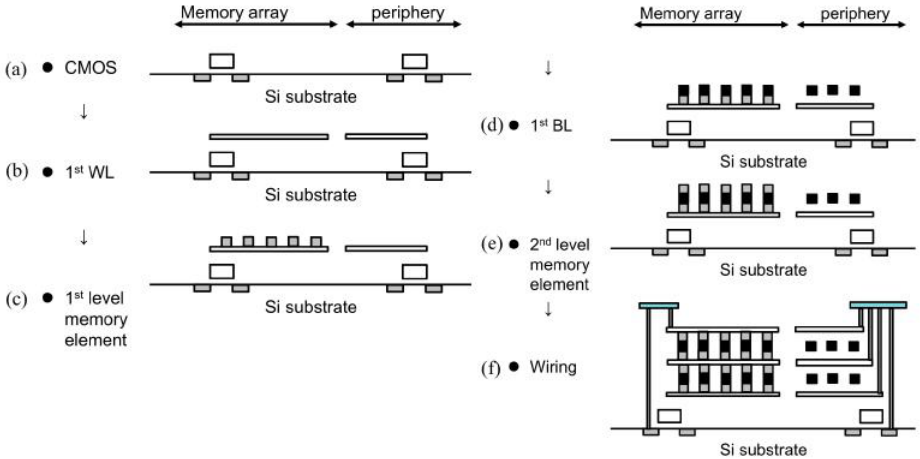
Figure 2. Fabrication steps from CMOS ( a ) through wiring ( b – f